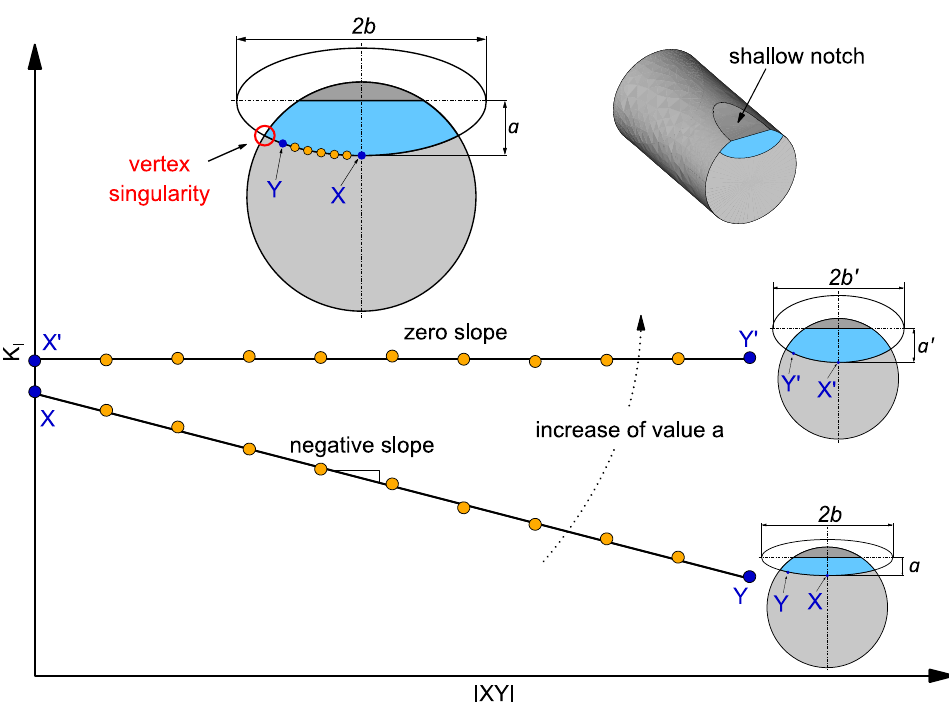
Figure 9. Scheme of procedure describing the numerical estimation of the real crack front shape.